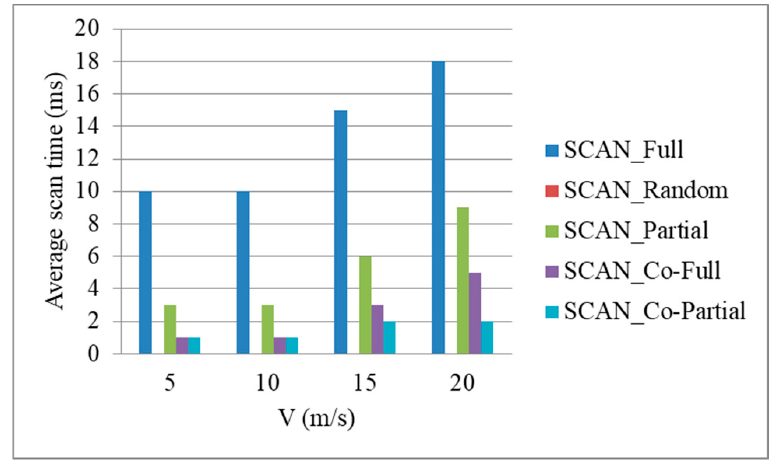
Figure 16. Average scan time under different number of SU cars (PU number = 10, P PUaccess = 0.5, V = 10).